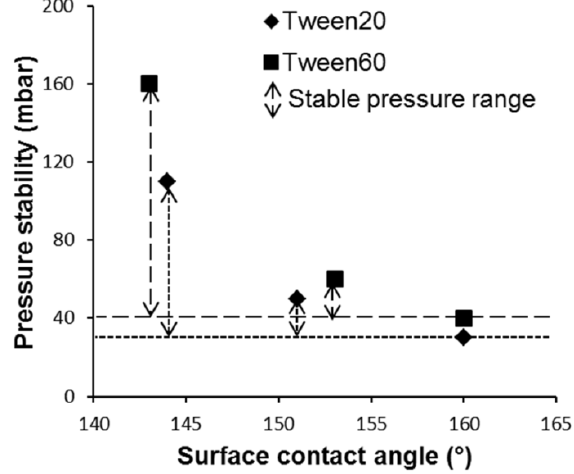
Figure 3. Pressure stability ranges of EDGE devices modified with silanes. The three phase contact angles in the presence of Tween 20 or 60 are given on the x -axis, and it is clear that the operational stability for direct emulsification is a strong function of the contact angle/surface wettability [41].